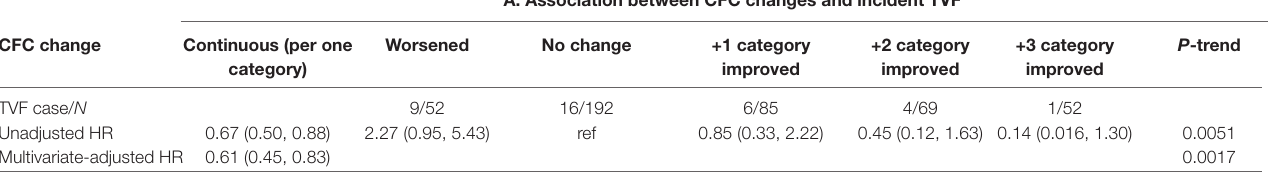
TABLE 5 | Association between CFC changes following PCI and incident target vessel